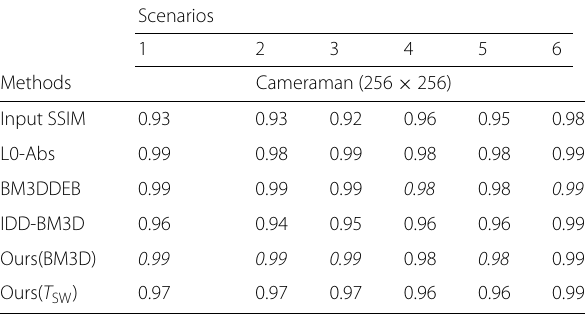
Table 3 SSIM of the four methods in six scenarios